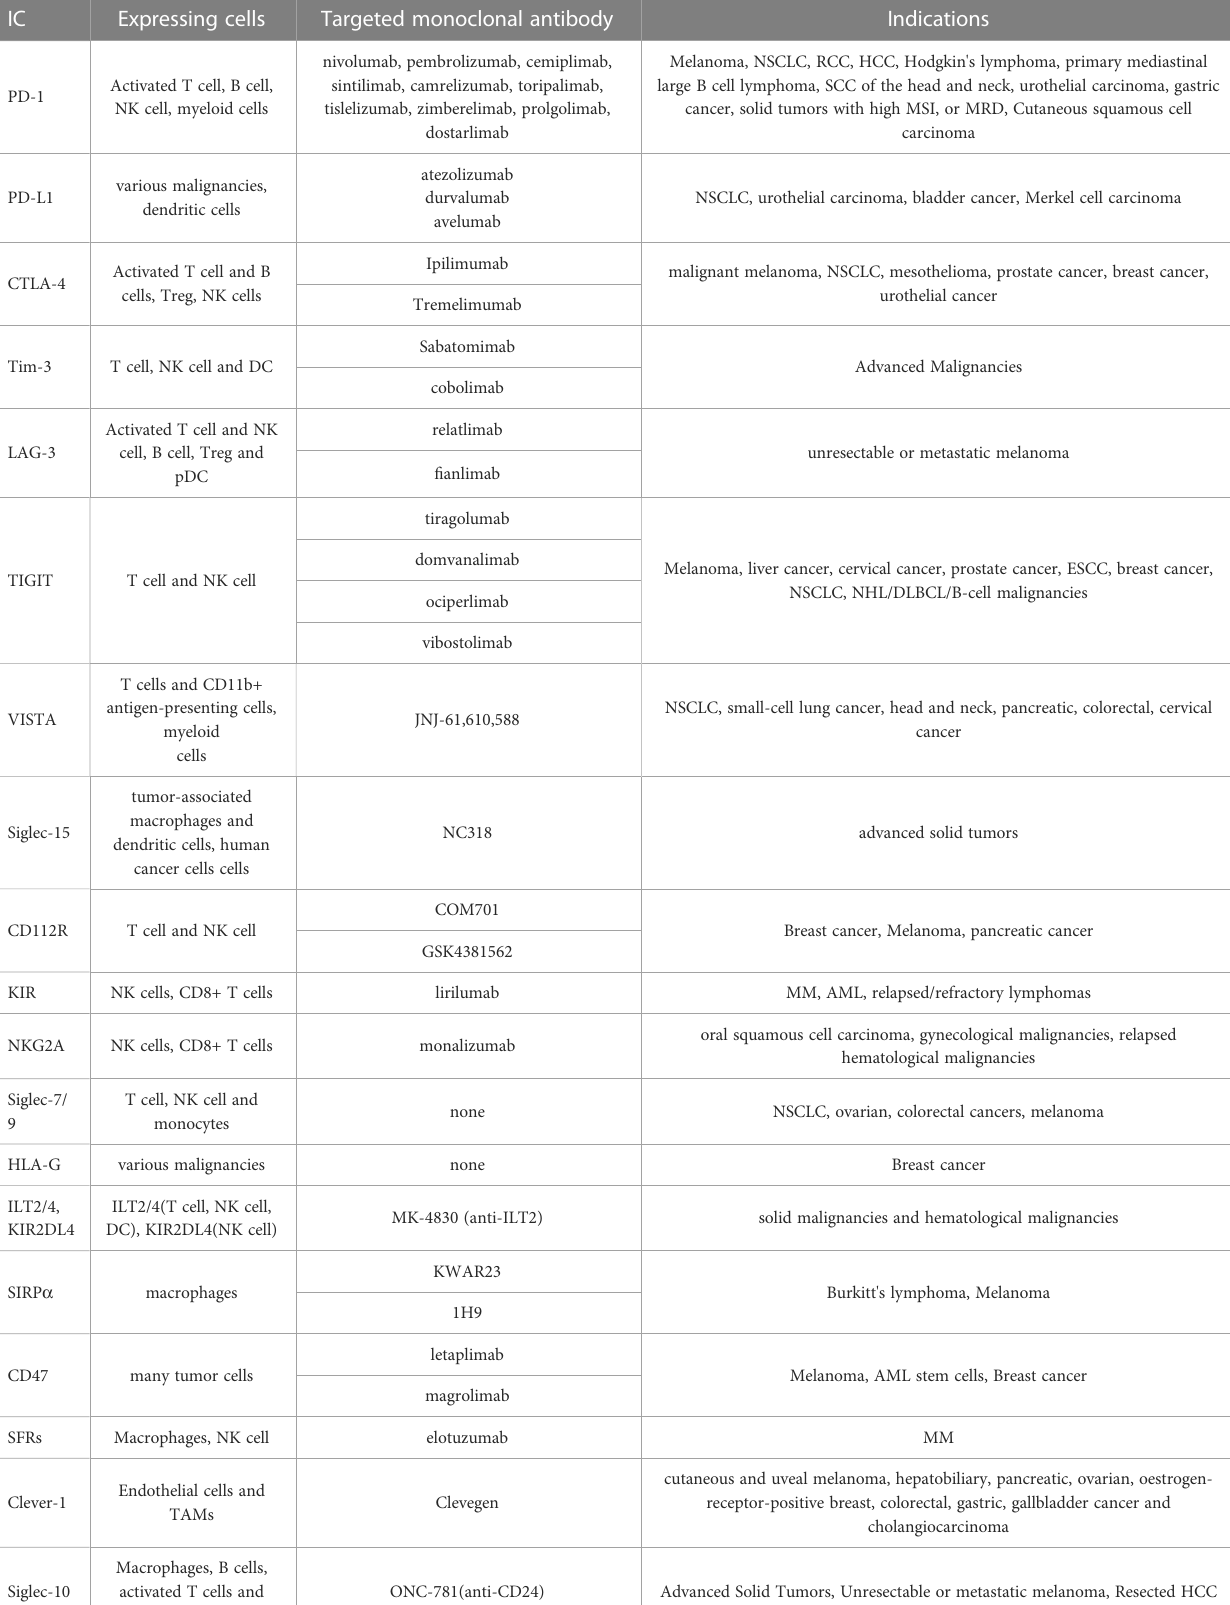
TABLE 1 The description of IC molecules 、 targeted monoclonal antibody drugs and